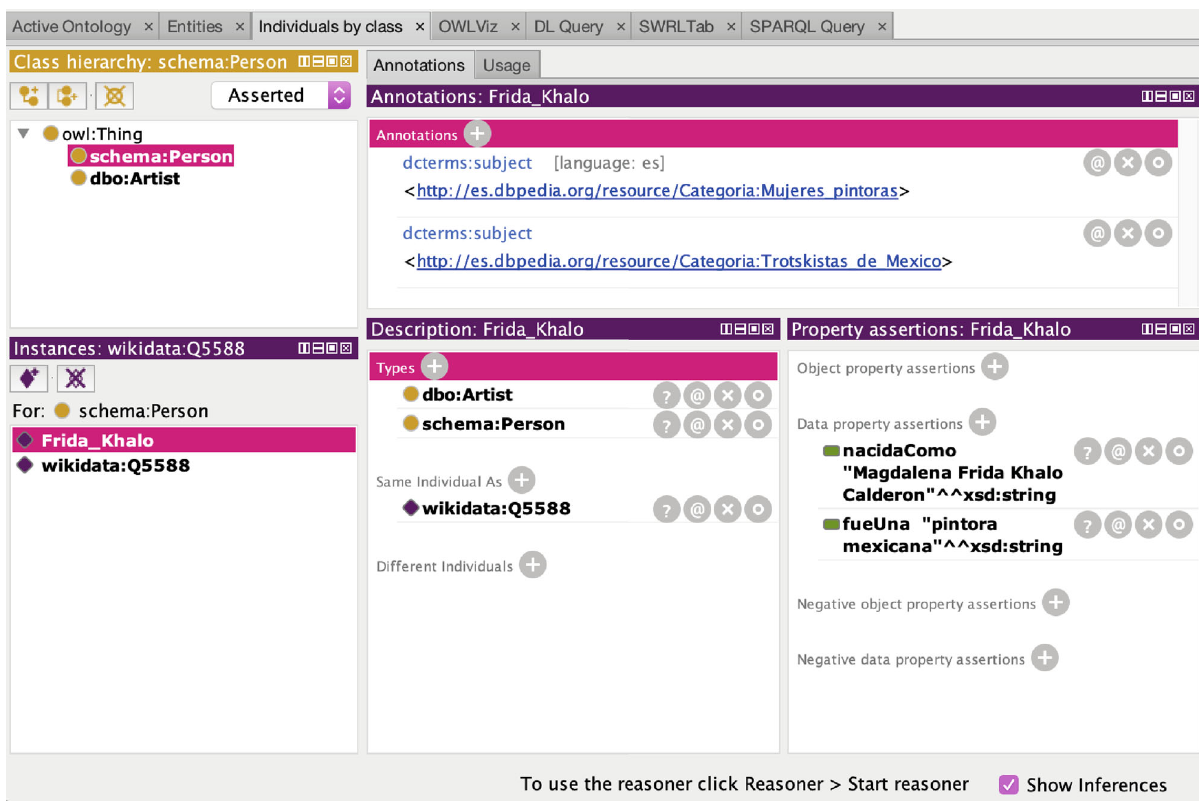
Fig. 3 RDF data visualization in Protégé